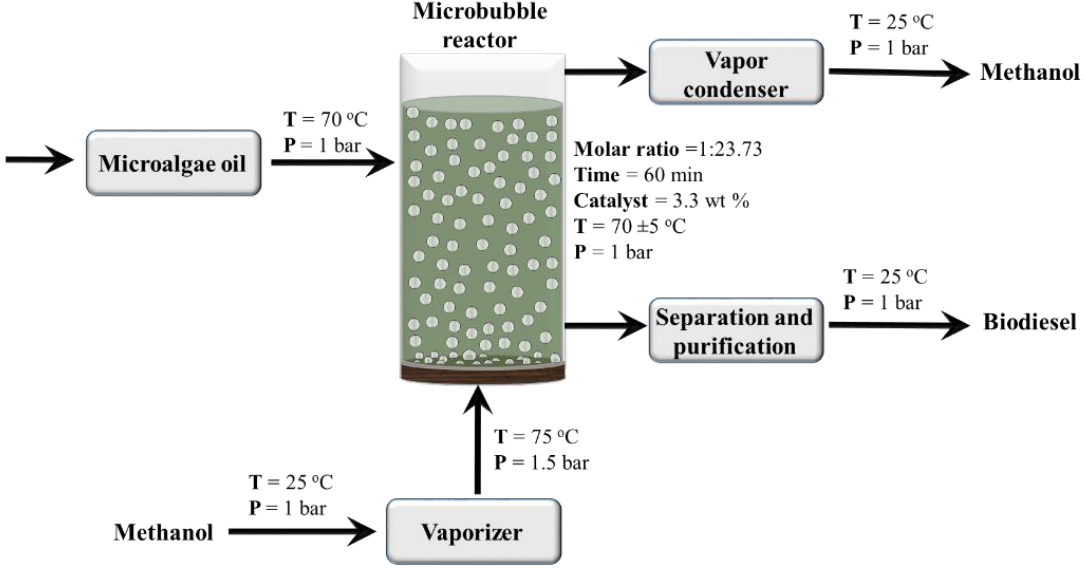
Figure 1. Process flow diagram of scale-up microbubble reactor .